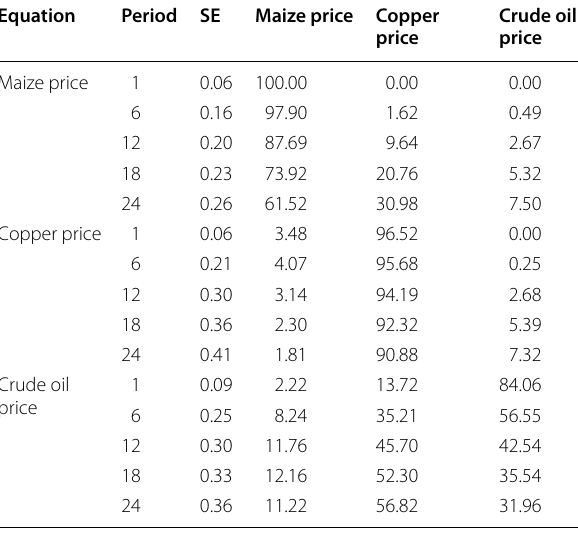
Table 12 Variance decomposition of maize, copper and crude oil prices (2000 to 2021 data) Equation Period SE